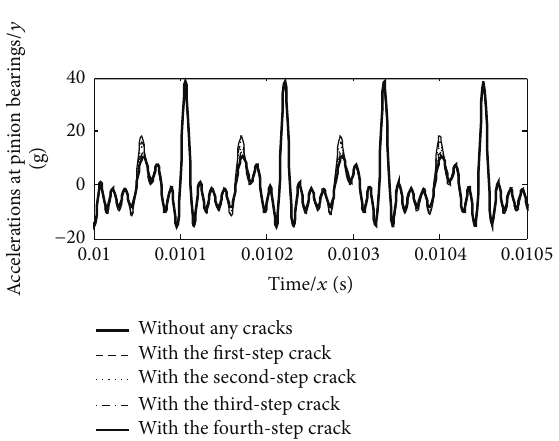
Figure 13: The simulation of pinion remote bearing accelerations of the example case.